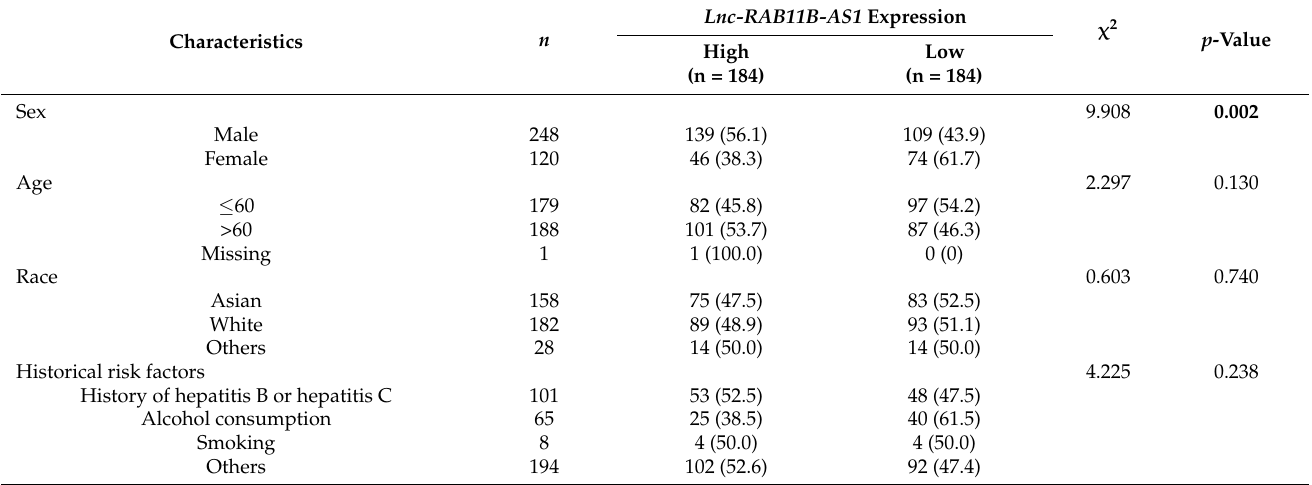
Table 1. Relationship between clinicopathological characteristics and expression of lnc-RAB11B-AS1 .